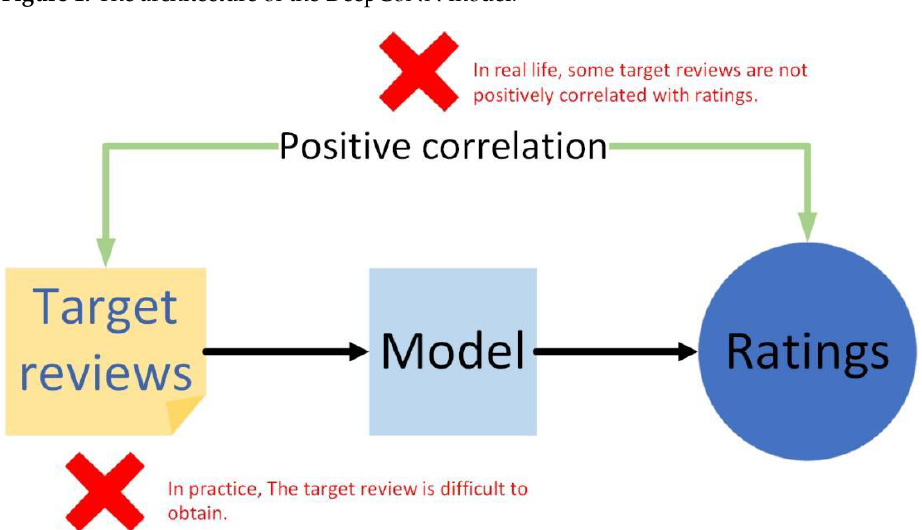
Figure 1. The architecture of the DeepCoNN model.